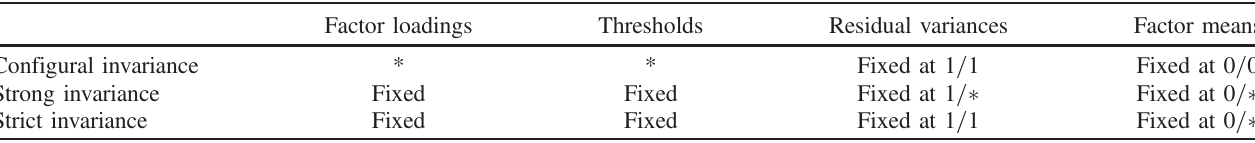
TABLE III. Testing for longitudinal measurement invariance with categorical data. The asterisk (*) indicates that the parameter is freely estimated across test time points. Fixed ¼ the parameter is fixed to equity in the pre- and post-test. Fixed at 0 = 0 ¼ factor means parameters are fixed at 0 at both pre- and post-test. Fixed at 0 = (cid:2) ¼ factor means parameters are fixed at 0 at pretest and freely estimated at post-test. Fixed at 1 = 1 ¼ the residual variances are fixed at 1 at both pre- and post-test. Fixed at 1 = (cid:2) ¼ the residual variances are fixed at 1 at pre-test and freely estimated at